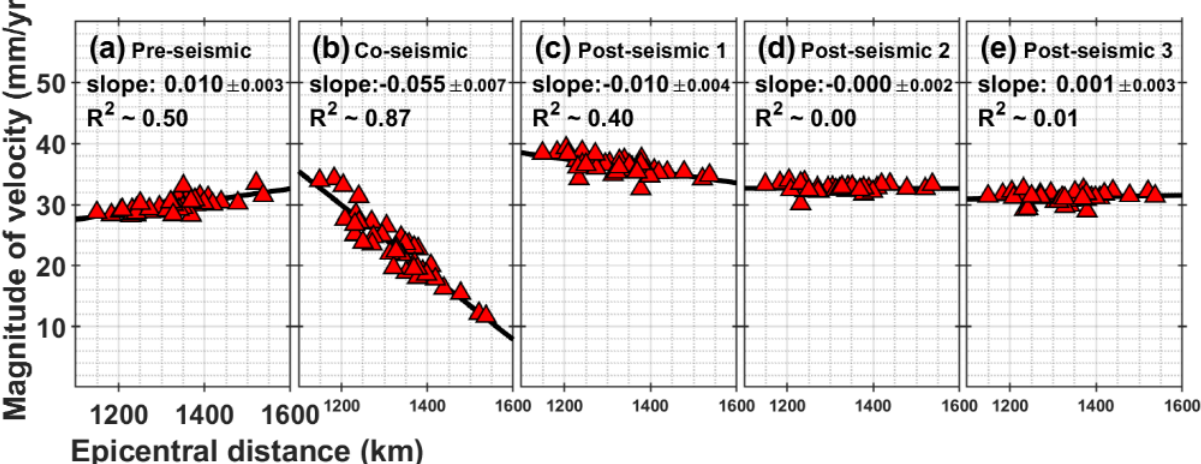
Figure 2. Magnitude of the horizontal GNSS velocity vectors with epicentral distance for each station in the five periods (i.e., ( a ) Pre-seismic, ( b ) Co-seismic, ( c ) Post-seismic 1, ( d ) Post-seismic 2, ( e ) Post-seismic 3) from 2005 to 2019. The red triangles represent the magnitudes of the velocity vectors for the GNSS stations in mm per year. The solid black lines (slope) are the best linear fits to the data. The coefficients and 95% confidence intervals for ‘slope’ are calculated as the linear relationship between two variables. R 2 is the coefficient of determination for a best-fit line. Note: In the ( b ) co-seismic stage, the unit of magnitude is mm. It is a total displacement, not a rate.